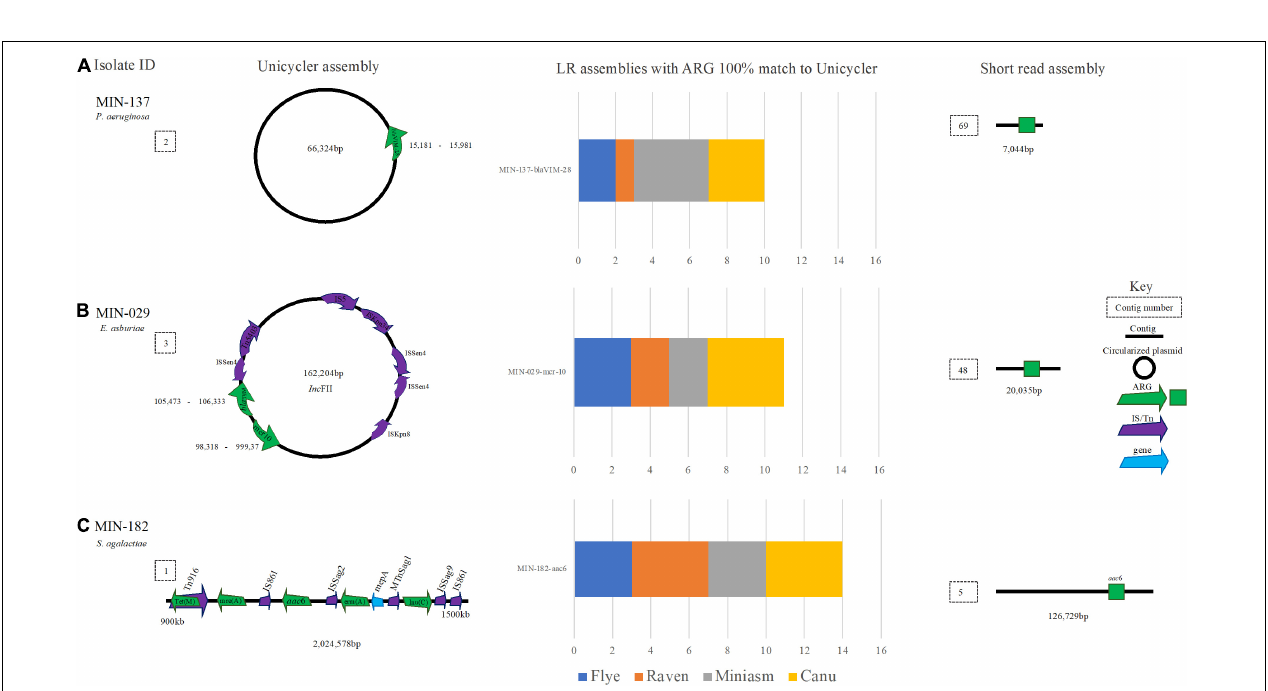
FIGURE 9 | A schematic to compare ARG detection from the Unicycler (hybrid) assembly (left), with the short read (SR) assembly (right). The stacked bar graphs (center) denote the number of LR assemblies with a 100% match to the Unicycler assembly. (A) MIN-137, an P. aemginosa isolate with bla VIM-28 located on a plasmid. (B) An E. asburiae isolate MIN-029 with blaTEM and mcr-10 located on a plasmid, (C) MIN-182 and S. agalactiae isolate with aminoglycoside and macrolide antibiotic resistance genes.